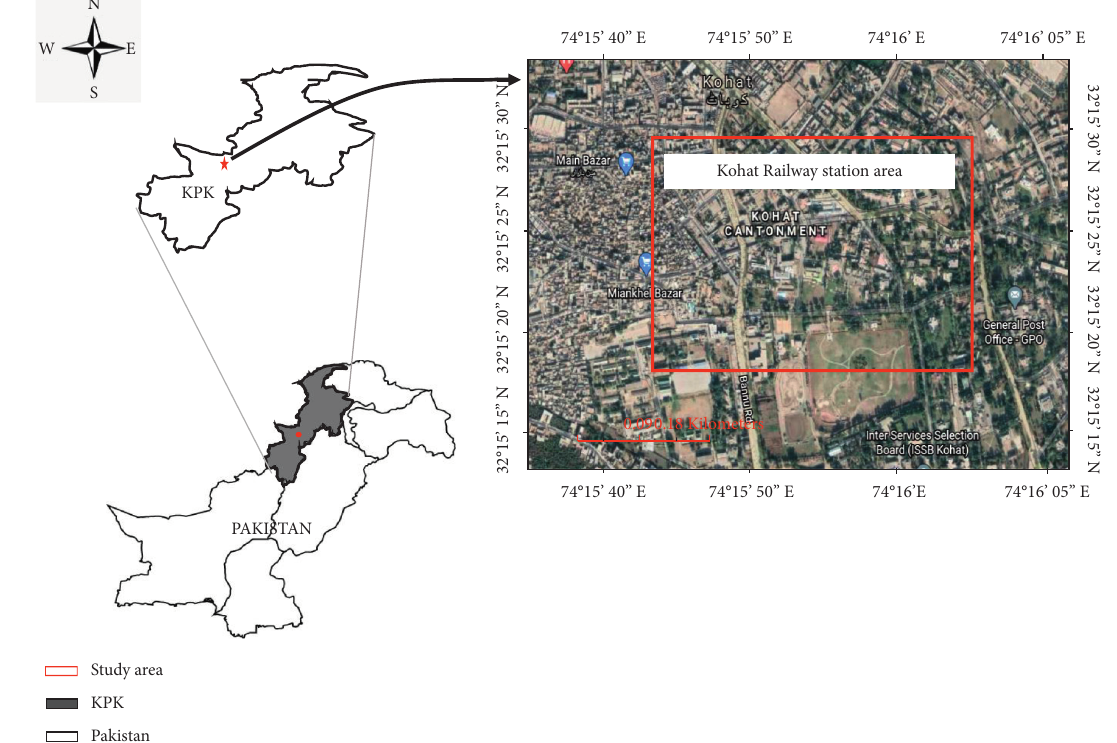
Figure 3: Location of study area (highlighted). Table 1: Physical properties of Palygorskite-rich expansive